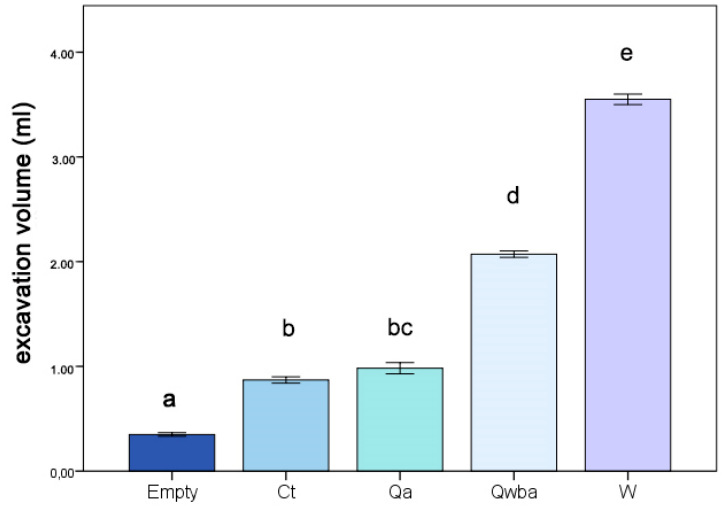
Figure 7. Total excavation volume (mL) in colonized galls according to colony composition: a: empty galls; b: galls with a queen of C. truncata ; c: galls with a queen of C. scutellaris and aphids (Qa); d: galls with queen, workers, brood of C. scutellaris and aphids (Qwba); e: galls with workers of C. scutellaris only. The SE interval is shown for each bar. The bars with the same letter are not statistically different (one-way ANOVA, see text for further details).